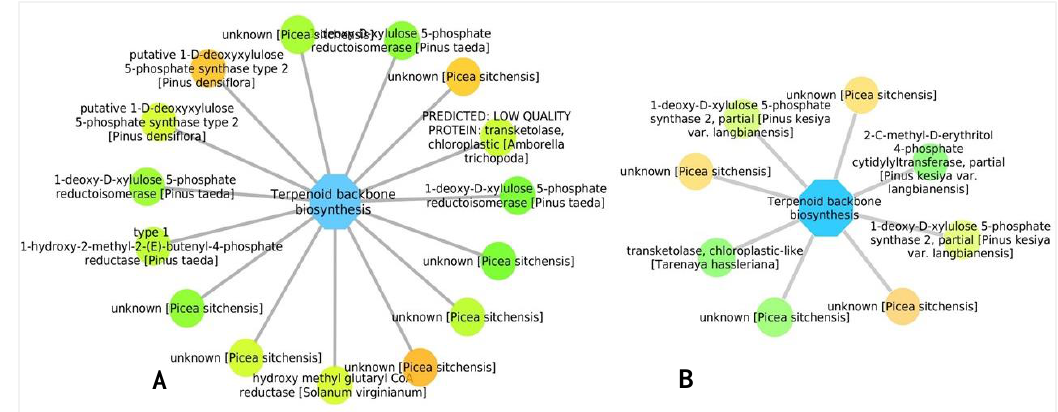
Figure 9. Terpenoid backbone biosynthesis pathway with interactions assigned to DEG in Pinus pinaster ( A ) and in Pinus yunnanensis ( B ) at the first time point after inoculation (6 + 24 h). The blue node represents the pathway. The circular nodes represent DEG related to the pathway. Note that due to the complexity of representing the expression values of those genes in all the stages, the expression was colored on an RGB (red, green, blue) scale that goes from the most down-regulated in red to the most up-regulated in green.